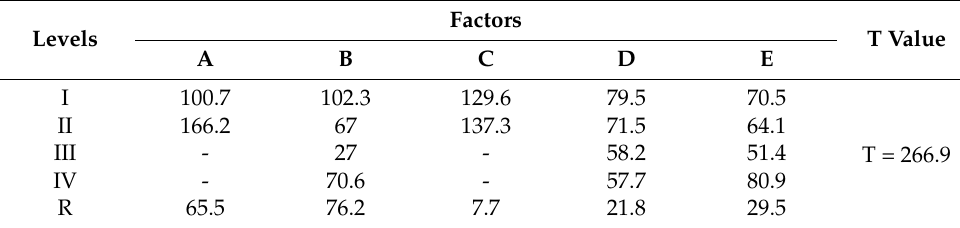
Table 8. Range analysis of the orthogonal experiment of paint film’s spalling